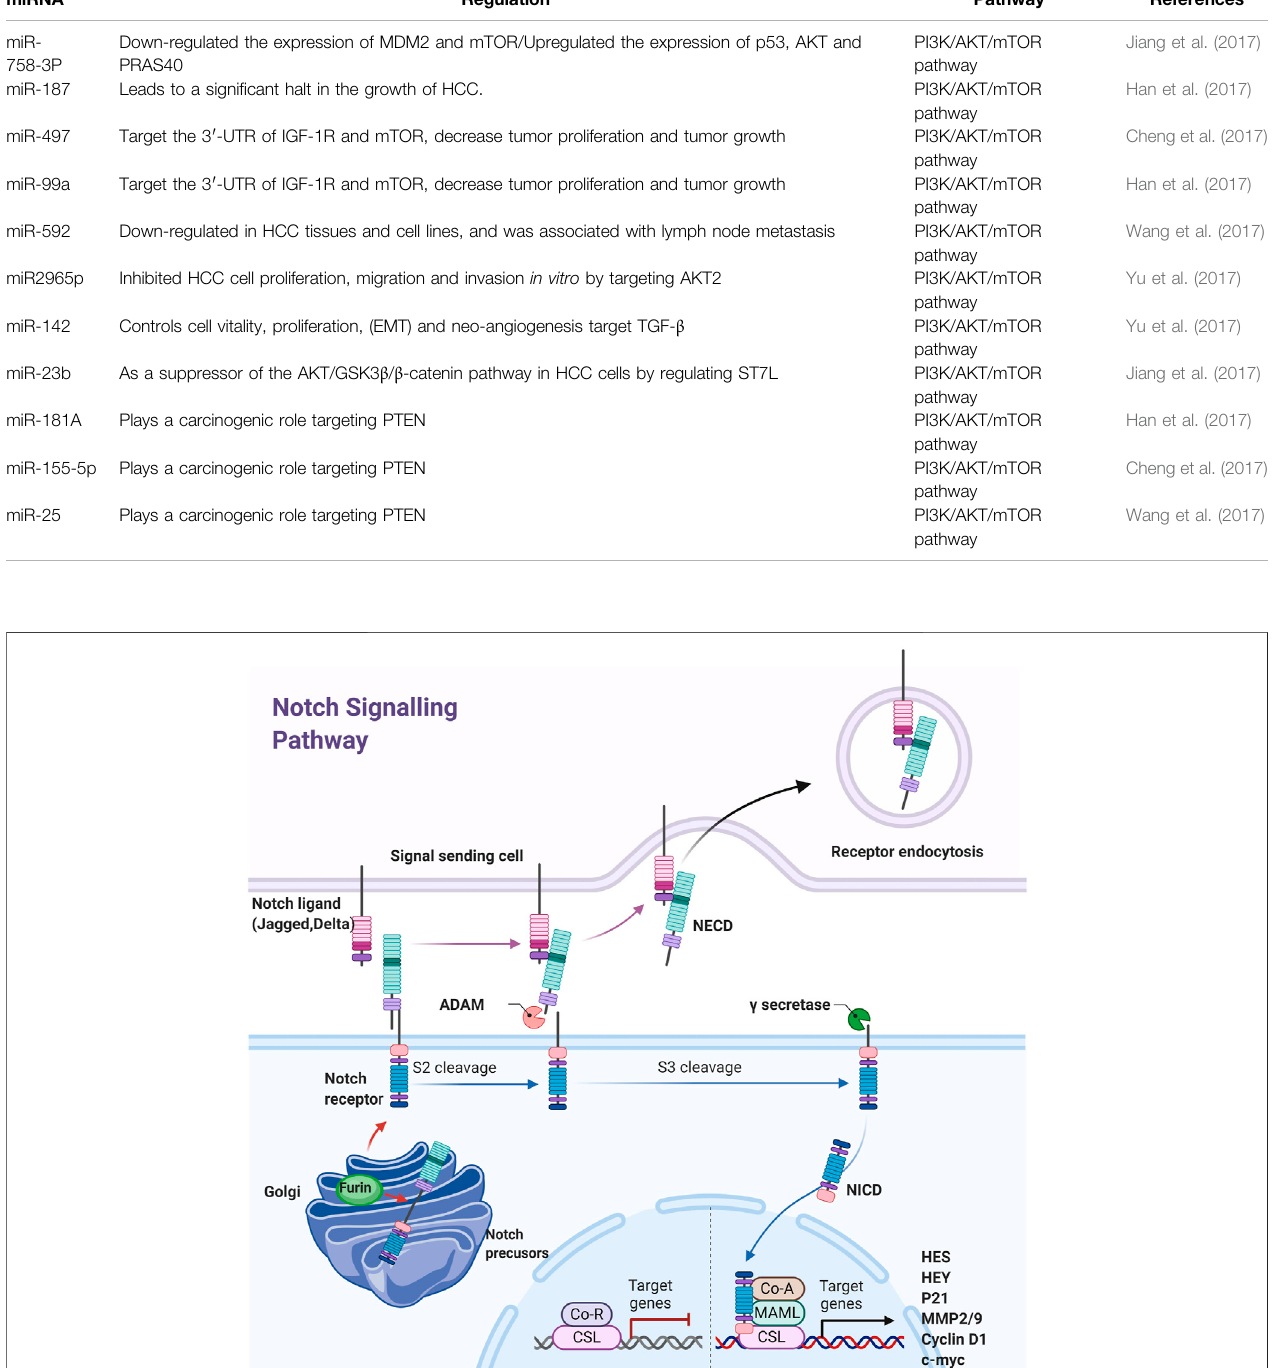
TABLE 4 | MicroRNAs regulate PI3K/AKT/mTOR pathway in liver cancer. miRNA